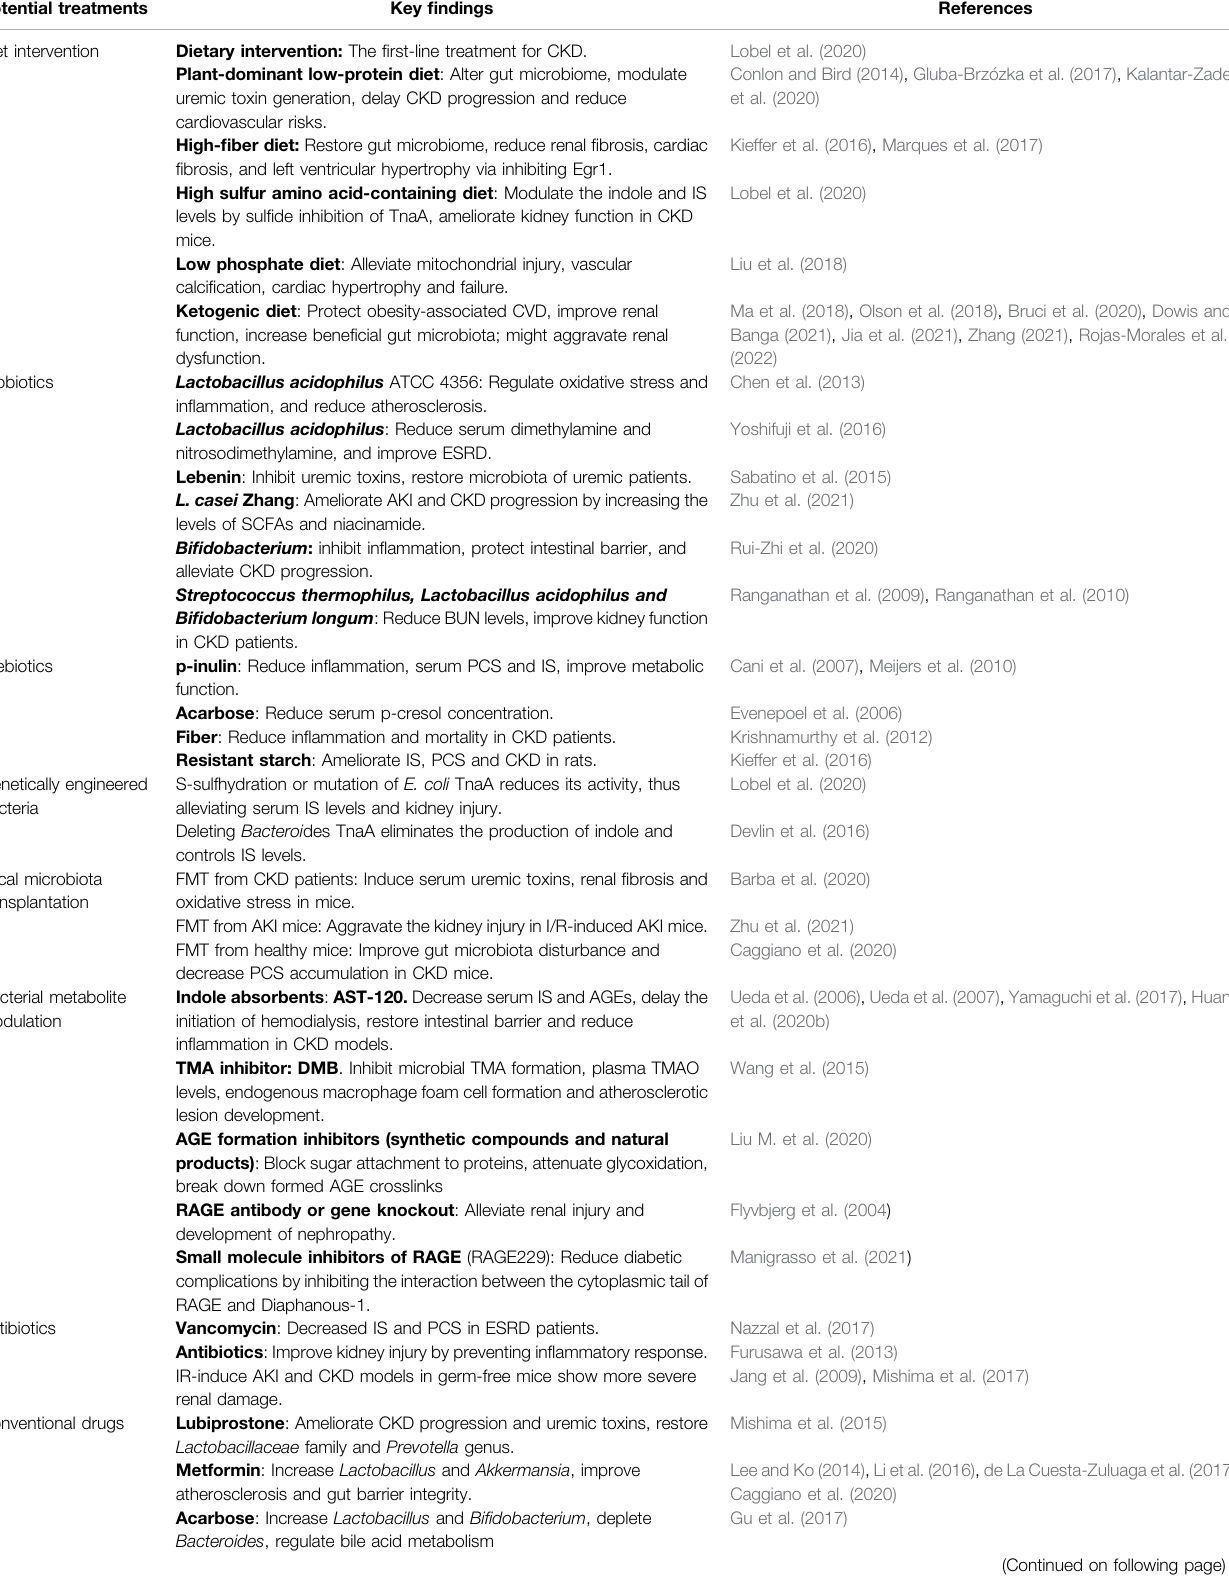
TABLE 3 | Potential treatments targeting microbiota in the gut – kidney-heart axis. Potential treatments Key fi